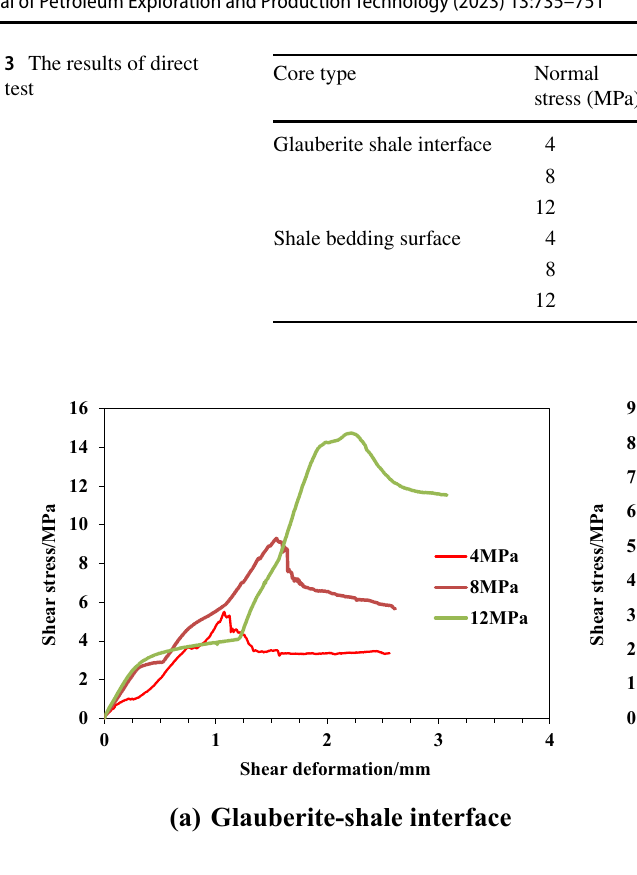
Fig. 8 Shear stress–shear displacement curve under different normal stress